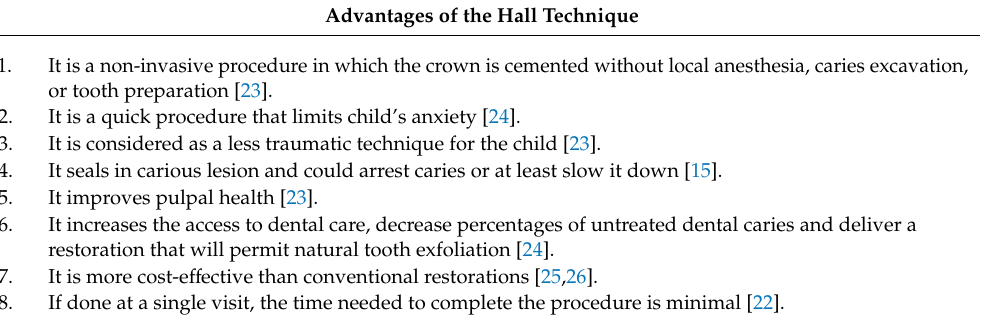
Table 2. Advantages of the Hall Technique for managing carious primary molars.